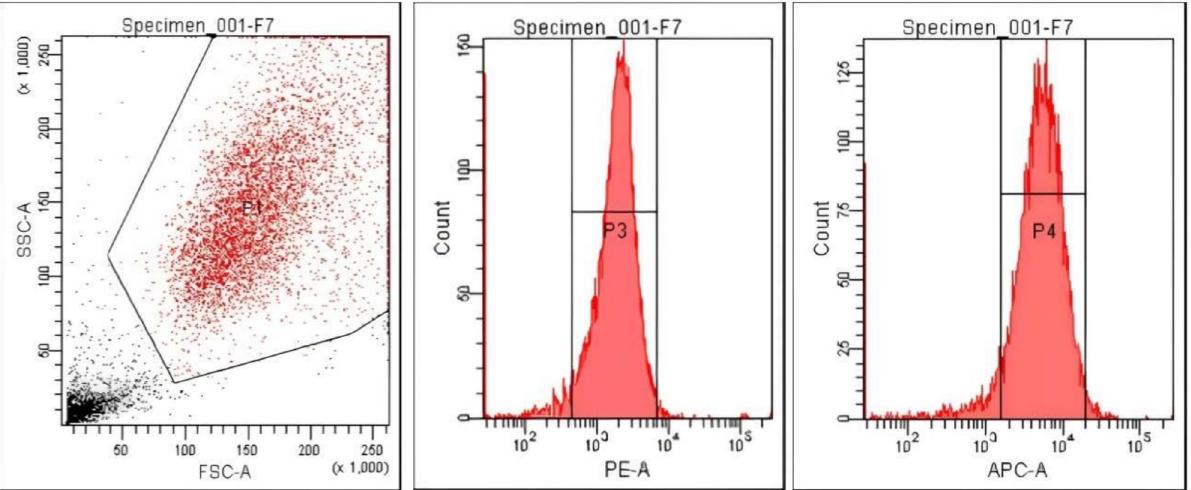
Figure 1. Dot-plot of cellular population and histograms corresponding to ICAM-1 (APC-A) and VCAM-1 (PE-A) signals.